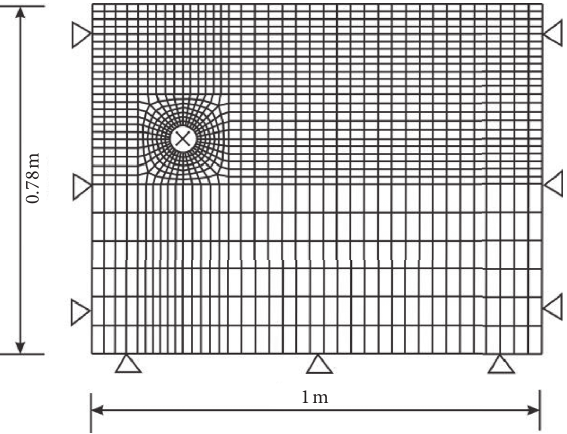
Figure 6: Element meshes of a numerical model.